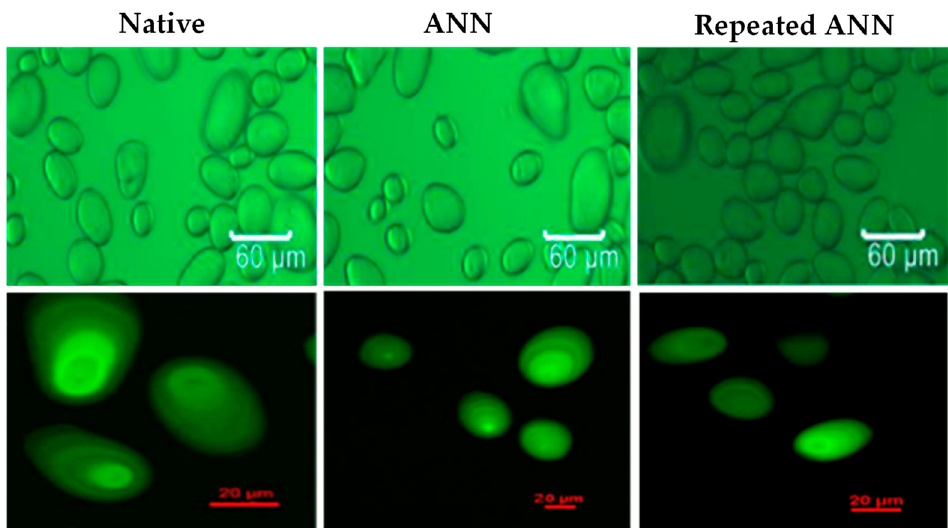
Figure 4. Starch granule morphology after hydrothermal treatment was analyzed by light microscope (LM) (above) and confocal laser scanning microscope (CLSM) (below) of potato starch [35], with permission from Elsevier, 2018.